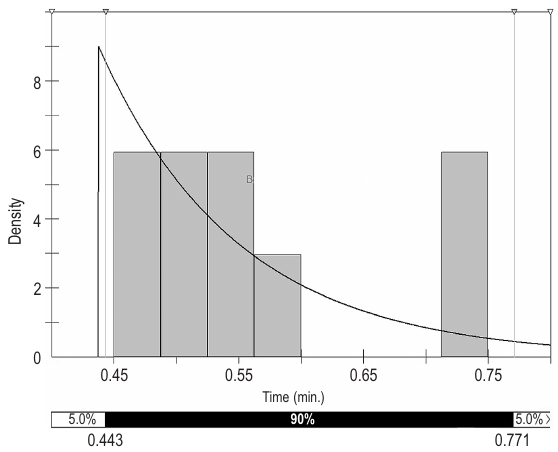
Fig. 10. Statistic distribution of the measured duration data for the activity of “ Dropping winch hook ” in the installing process after removing